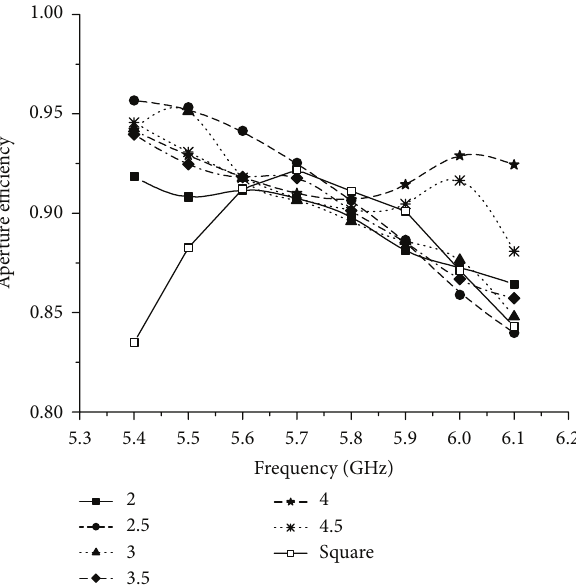
Figure 9: The simulated aperture efficiency of the different fractal proportion antenna array.